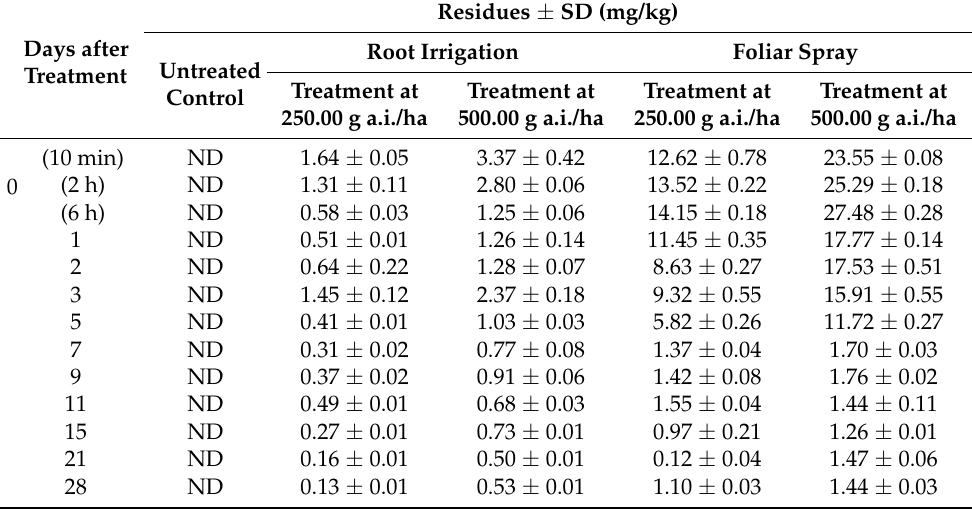
Table 3. Residues of fluopyram in the carrot